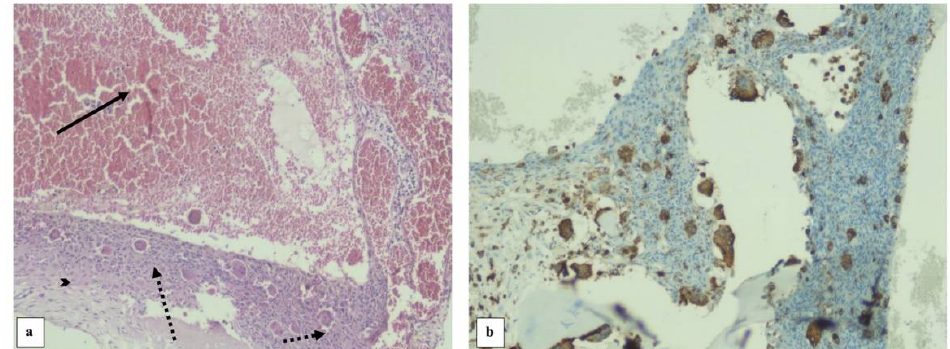
Figure 8. Histological specimen ( a ) showing large aneurysmal bone cyst-like changes (arrow), mononuclear cells (arrowhead) and osteoclast-like giant cells (round dotted arrows) in hematoxylin-eosin coloration at 100× magnification. Immunohistochemistry specimen at 100× magnification ( b ) was positive for CD68.